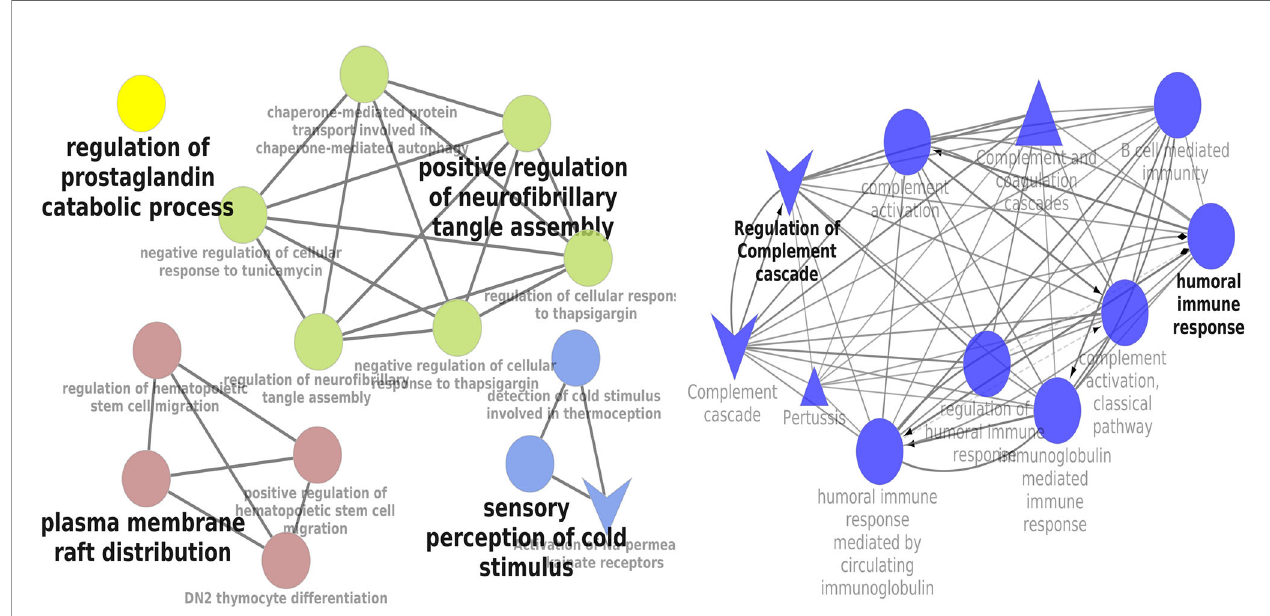
FIGURE 2 | Interrelation analysis of pathways upregulated DEGs by examining KEGG processes in ClueGO.